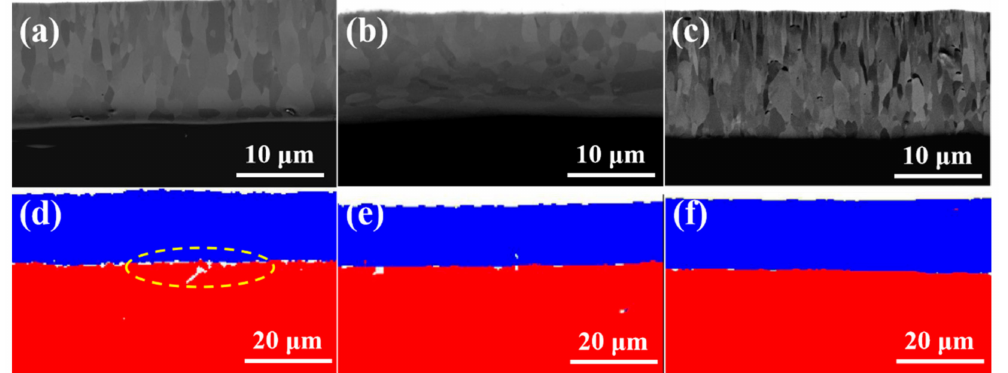
Figure 3. SEM images ( a – c ); and phase composition analysis by EBSD ( d – f ) of the cross-section of Cr coating samples #1, #2 and #3, respectively. Blue: Cr in the coating part; red: Zr in Zry-4 alloy